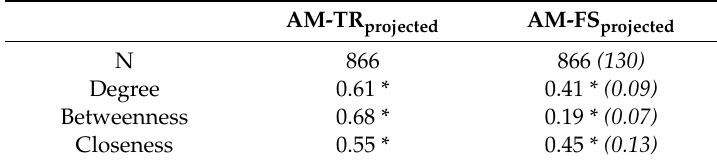
Table 4. Spearman rank correlation coe ffi cients between the centrality parameters of the animal movement network (AM) and the projected transportation network (TR projected ) as well as the projected feed supply network (FS projected ). Values marked with an asterisk (*) are significant ( p ≤ 0.05). For the projected feed supply network, the italic numbers in parentheses illustrate the values for the network calculated without isolated farms.